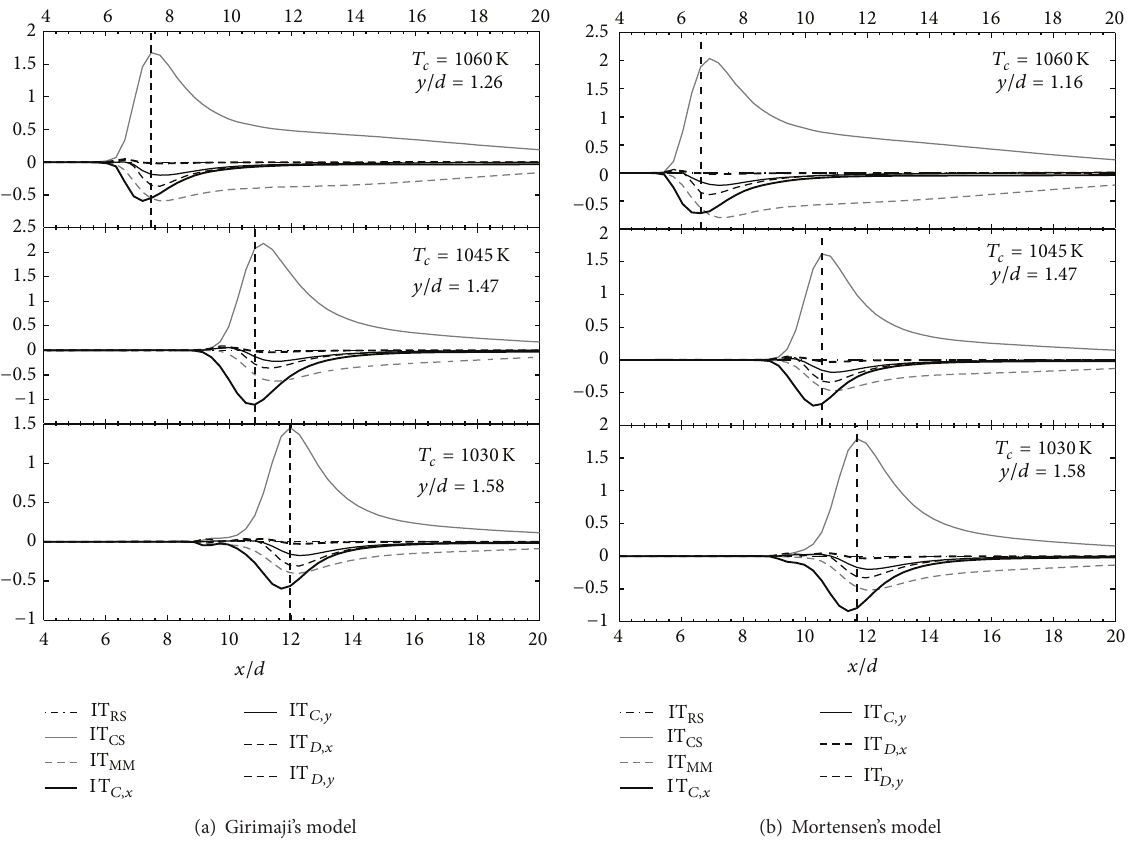
Figure 7: Axial profiles of the Integrated Transport (IT) budget of the steady-state 𝑄 𝑇 equation (integrated r.h.s. terms of (9)): (a) Girimaji’s model and (b) Mortensen’s model. The bottom, middle, and top panes correspond to 𝑇 𝑐 = 1030 K, 𝑇 𝑐 = 1045 K, and 𝑇 𝑐 = 1060 K,